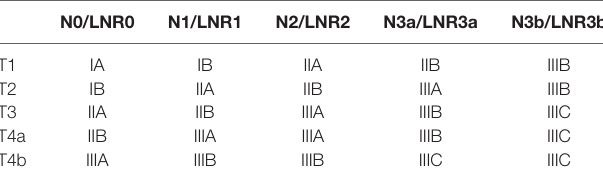
TABLE 1 | TRM/TNM staging